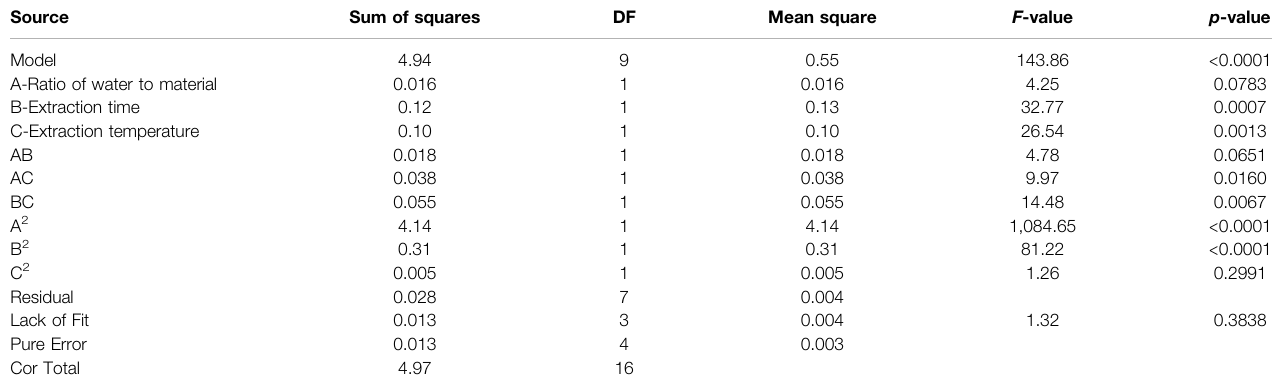
TABLE 2 | Regression Model and analysis of variance. Source Sum of squares Model A-Ratio of water to